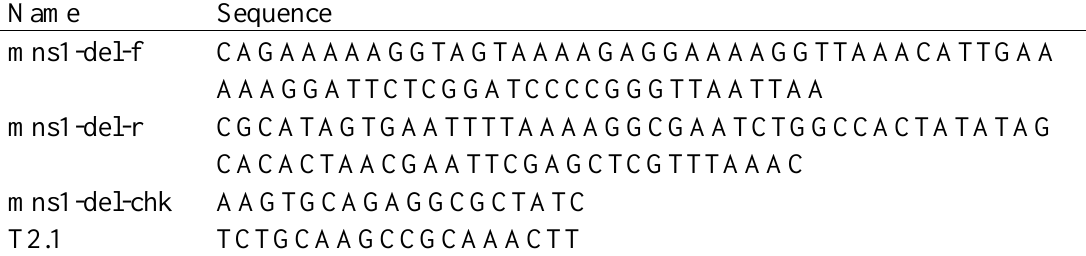
Table 2. Primers used in this